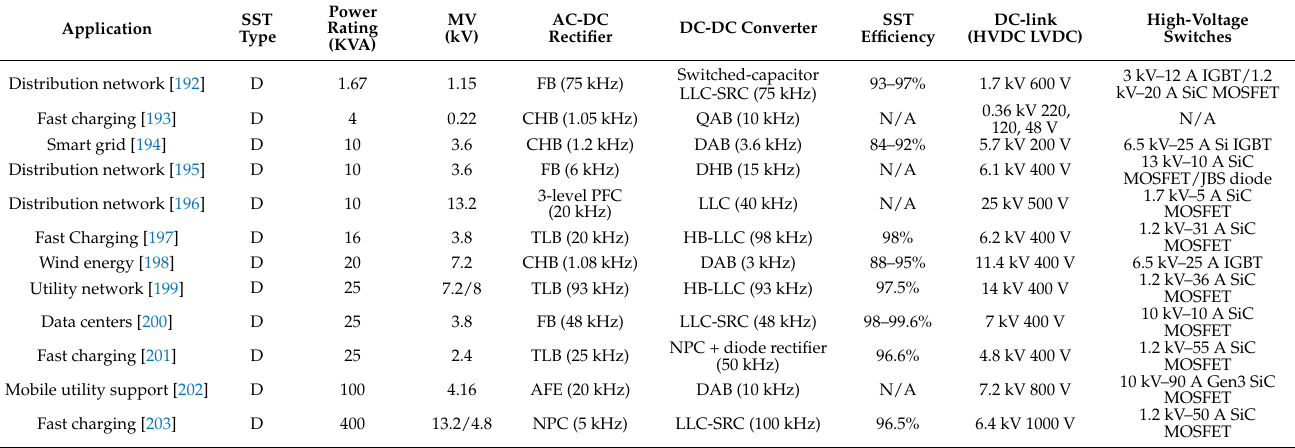
Table 4. Experimentally implemented SSTs in the literature for different